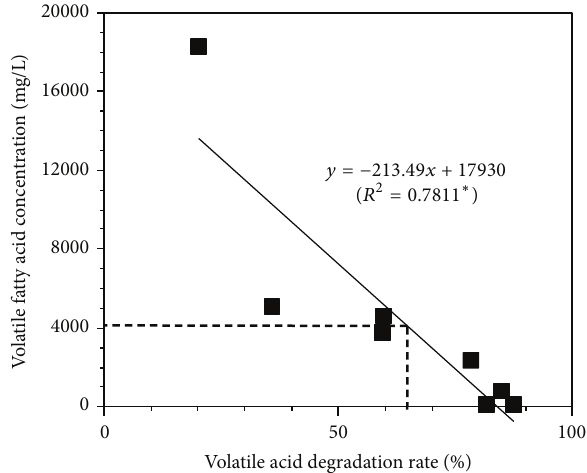
Figure 5: Relationship between volatile solid removal rate and volatile fatty acid concentration. ∗ denotes significance at 5.0%